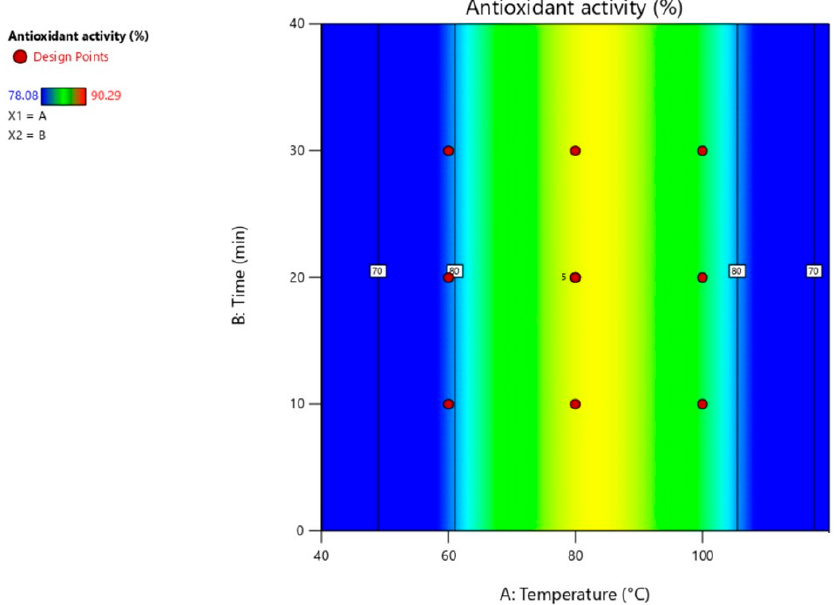
Figure 3. Two-dimensional contour diagram.